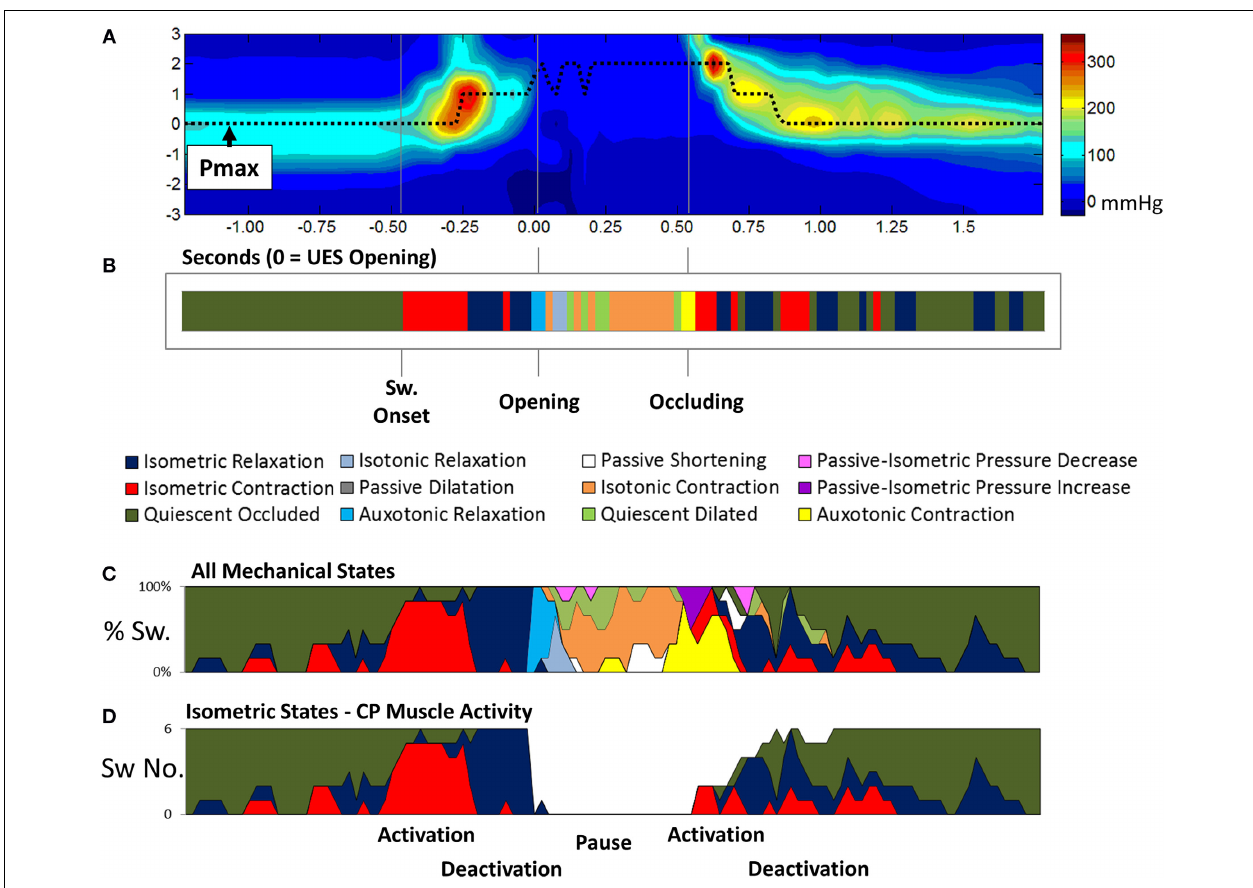
FIGURE 9 | Adaptation of the pressure-amittance mechanical states model to accommodate movement of the UES high pressure zone relative to the catheter. (A) Spatio-temporal pressure plot of an example pharyngeal swallow showing a region of interest encompassing the UES high pressure zone before, during and after swallow. Pmax shows the positon of maximal pressure defined at all time points and demonstrates the elevation of the sphincter that occurs before complete relaxation. (B) A representation